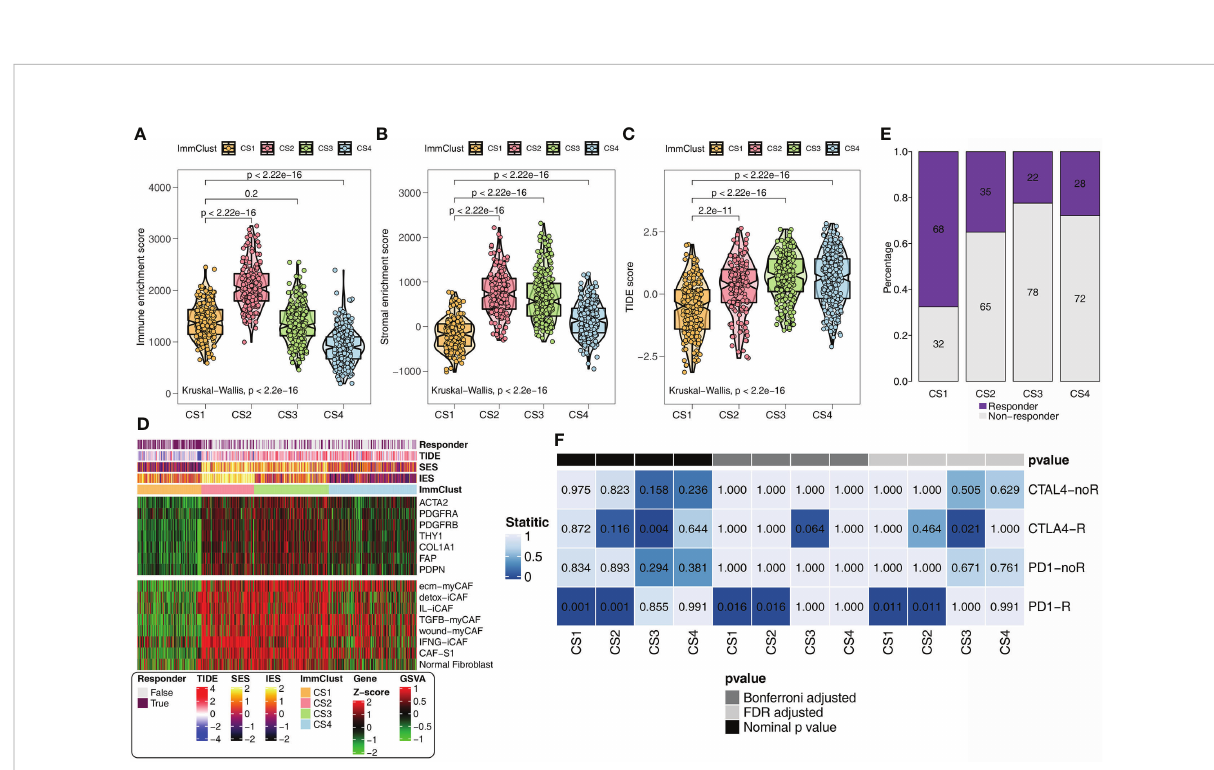
FIGURE 4 Immunotherapy response analysis for the GEO. (A) Immune enrichment score for the four ImmClusts. (B) Stromal enrichment score for the four ImmClusts. (C) TIDE score for the four ImmClusts. (D) Response to immunotherapy of the four ImmClusts. (E) SubMap analysis for the four ImmClusts. (F) The heatmap showed the differences in the distribution of the four ImmClusts in CAF-related genes and signatures.